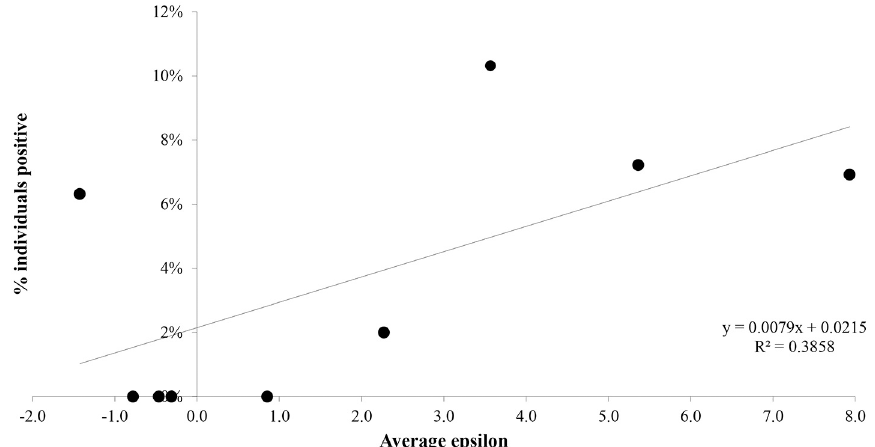
Fig 3. Graph of percentage of individuals identified as positive for presence of L . ( L .) mexicana versus mean epsilon value.